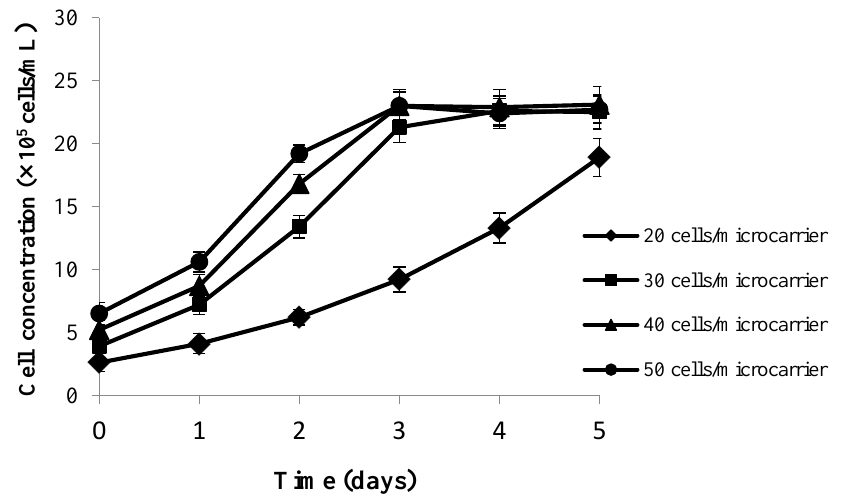
Figure 4. Growth curve of CPB cells at different inoculation densities. Bars show the mean ± SD, n = 3.